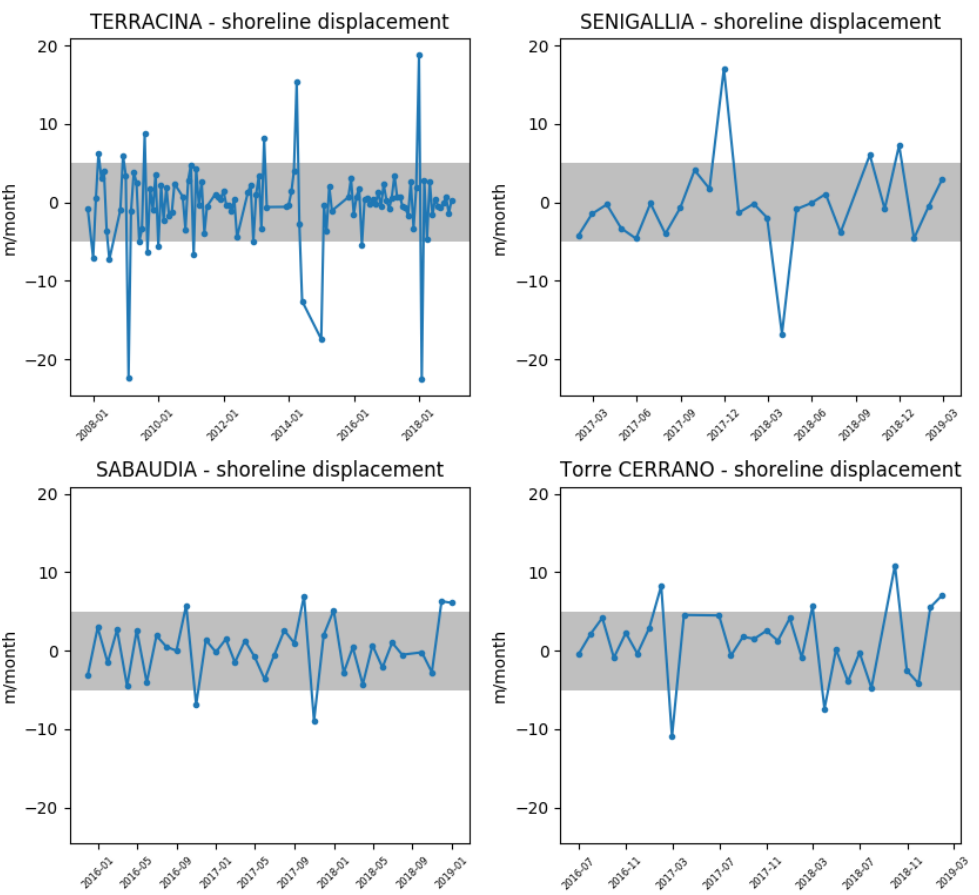
Figure 6. Maximum shoreline displacement rates at Senigallia, Torre del Cerrano, Terracina and Sabaudia, calculated from monthly-resampled time series of shoreline displacement. The shaded area indicates a displacement rate range from − 5 to +5 m/month. Negative values correspond to shoreline retreat, while positive values show shoreline